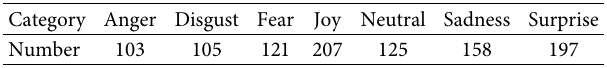
Table 1: The number of videos per emotion category in HEIV